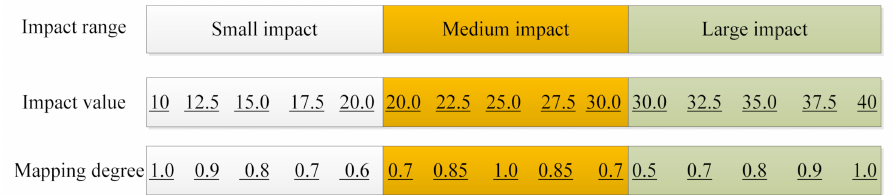
Figure 6. Ranges of risk impact along with values and their membership degree.